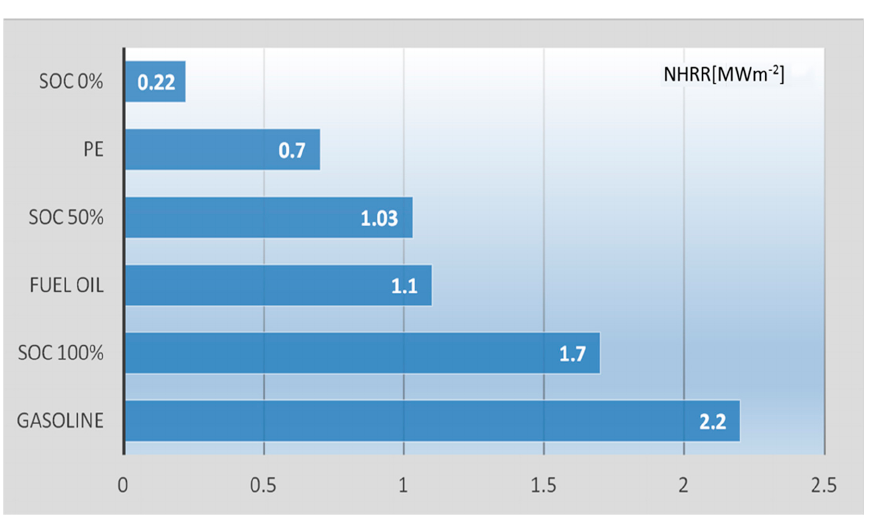
Figure 3. Normalized HRR (MWm − 2 ) for two fuels and polyethylene compared to 0%, 50% and 100% SOC batteries (Own elaboration on the basis of the data from [18]).